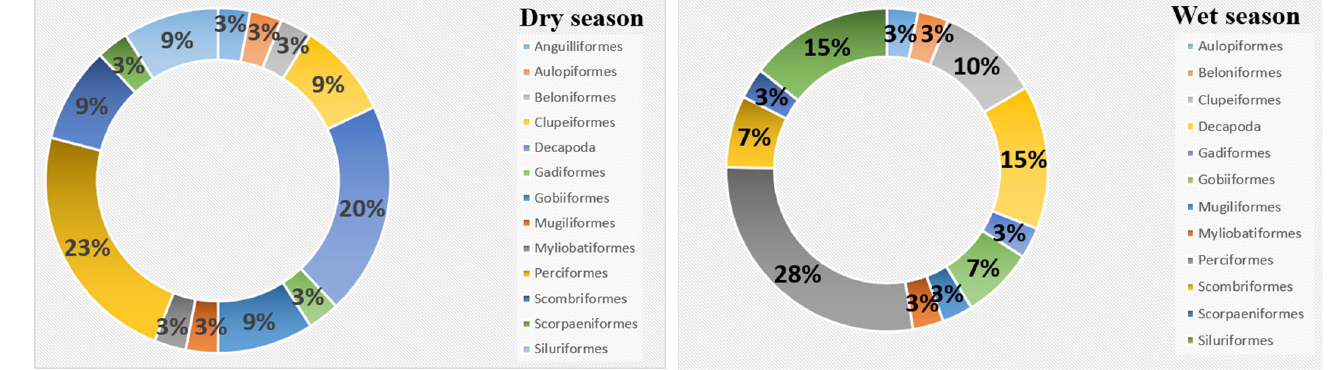
Figure 4. Percentage orders of fish species in the MRE during the dry and wet seasons. Recorded fish species from the orders Decapoda (4.0–13.5 psu), Mugiliformes (1.0–13.0 psu), Beloniformes (1.0–9.0 psu), Perciformes (1.0–12.5 psu), Clupeiformes (1.0–9.0 psu), Gobiiformes (1.5–9.0 psu), Siluriformes (1.5–8.5 psu), Aulopiformes (2.0–12.0 psu), Scorpaeniformes (2.5–12.5 psu) and Scombriformes (2.5–12.0 psu) were found to tolerate wide ranges of salinity. Meanwhile, fish species from the orders Gadi- formes (6.0–11.0 psu) and Myliobatiformes (2.5–7.0 psu) were available in moderate ranges